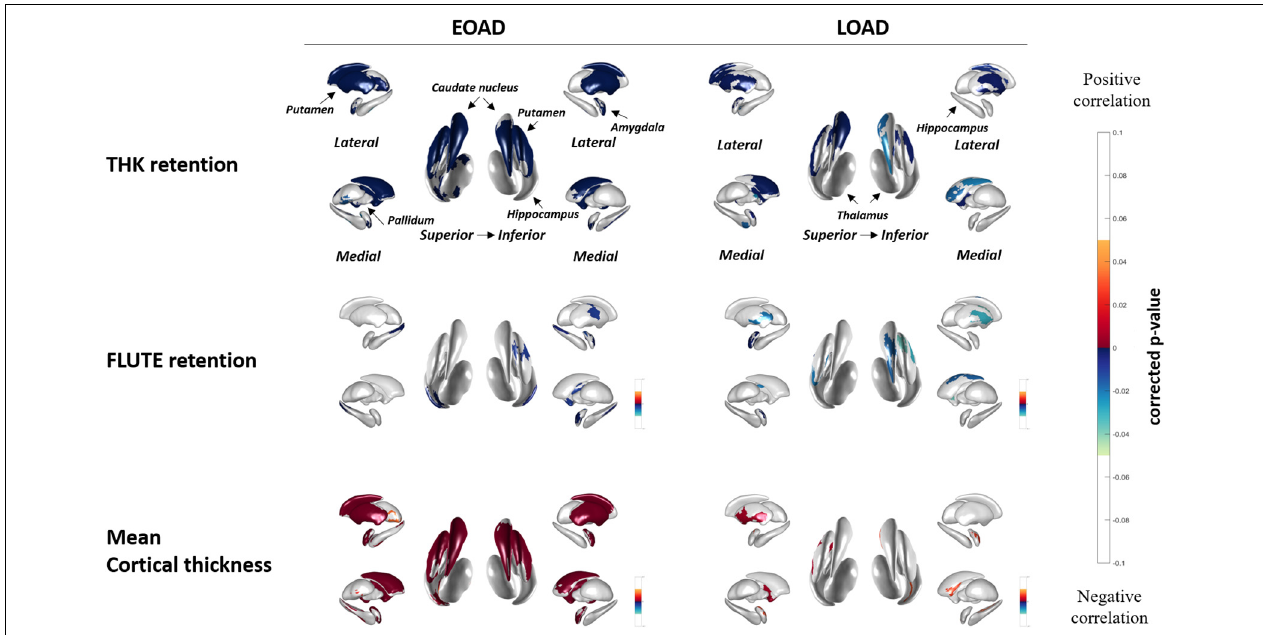
FIGURE 2 | Spearman correlation between subcortical local shape and THK5351 retention, FLUTE global retention, and mean cortical thickness in EOAD and LOAD, adjusting with age, sex, years of education, and intracranial volume (ICV) in each EOAD and LOAD group. The mapped p -values are multiple corrected using cluster-based statistics. Abbreviations: EOAD, early onset Alzheimer’s disease; LOAD, late-onset Alzheimer’s disease.